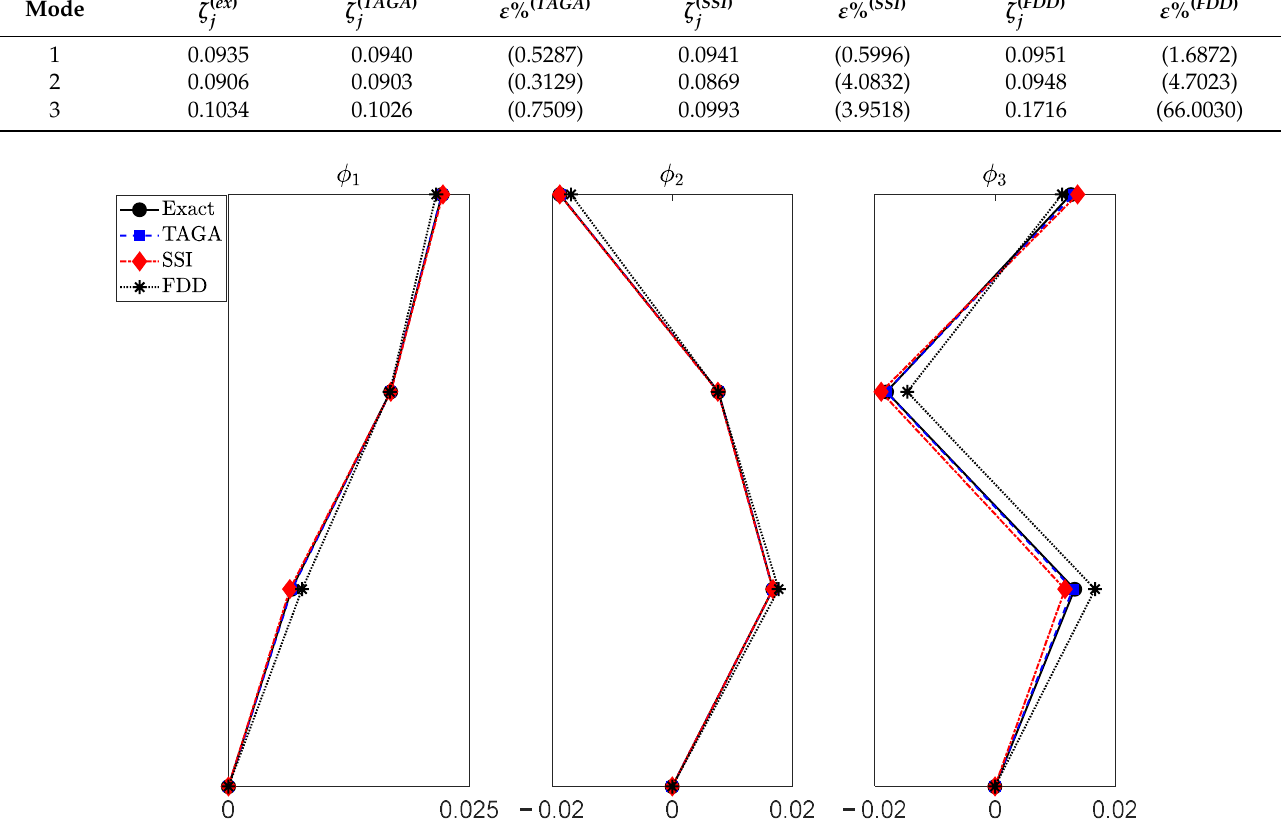
Figure 3. Comparison between the identified modal shapes and the exact ones for the 3DoF system.